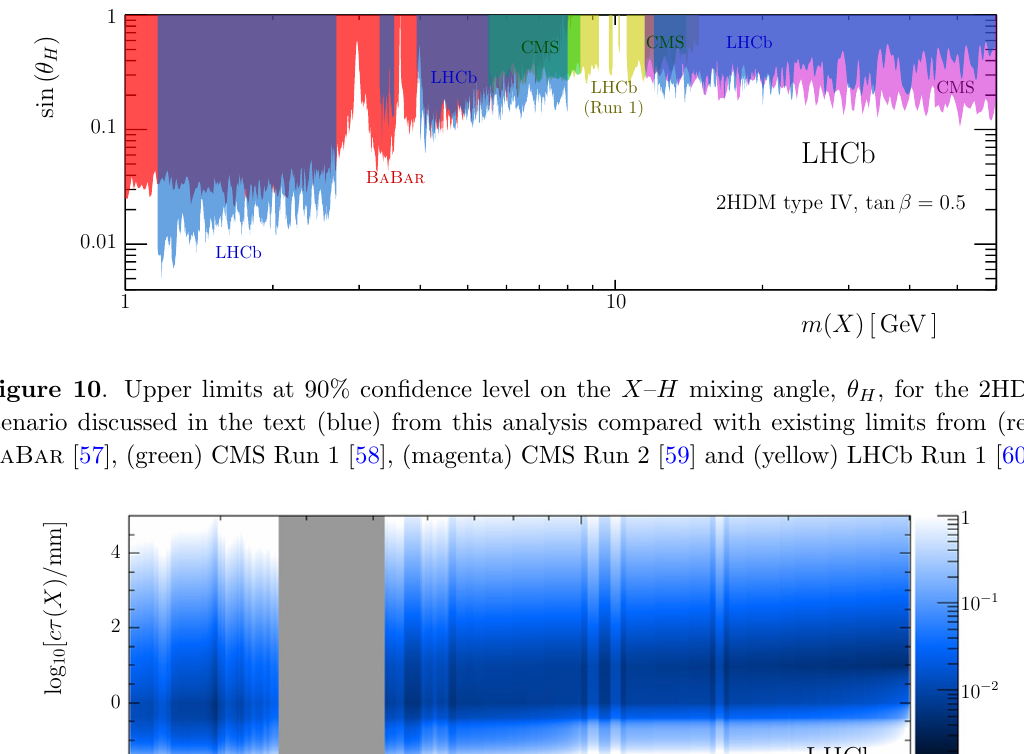
HV kinetic mixing strength for the HV